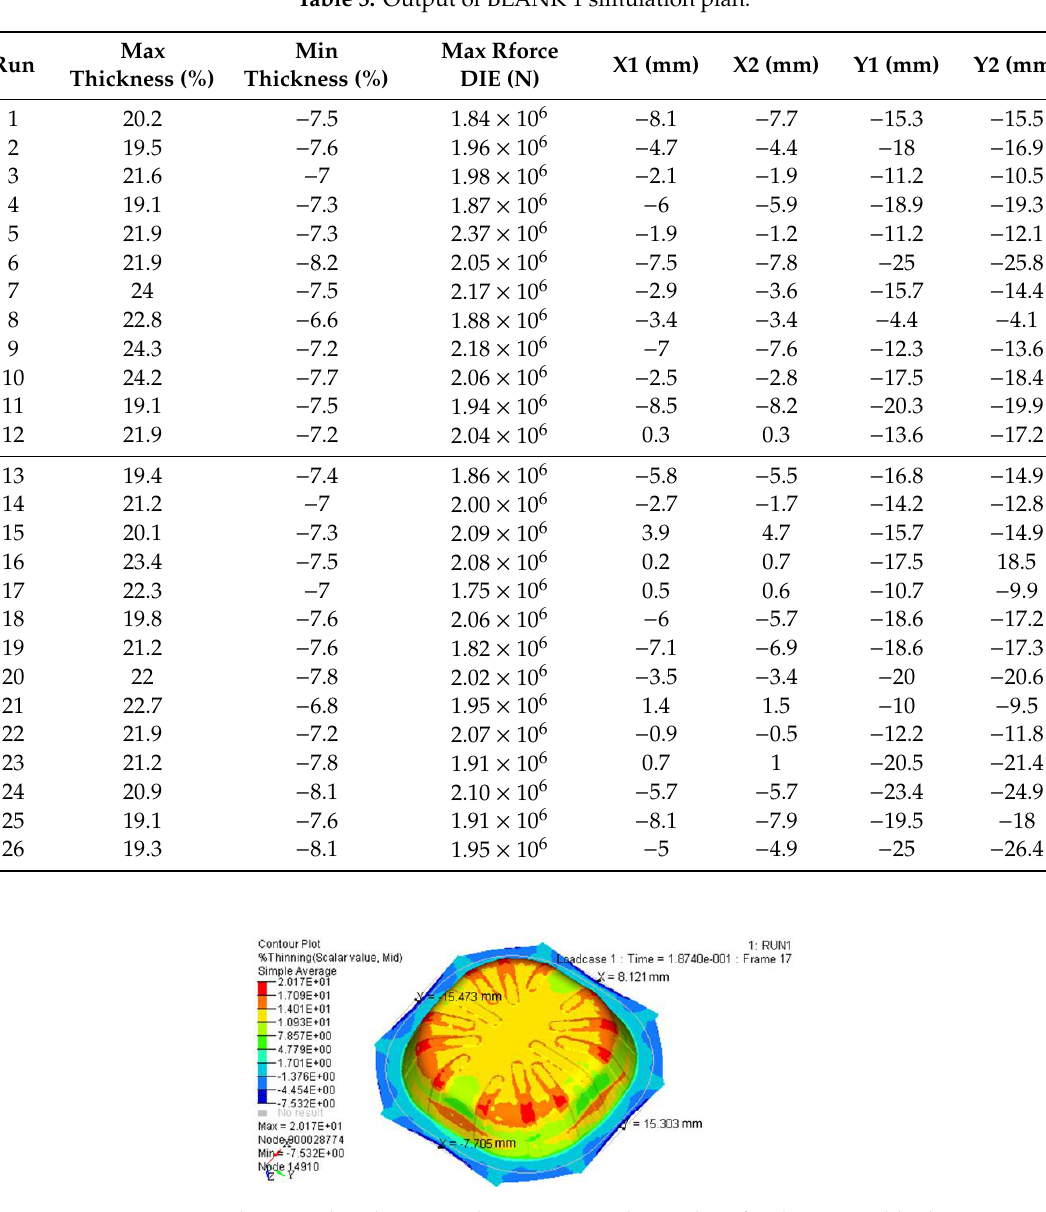
Figure 13. Reaction force curves comparison between RUN20 and RUN22; blank0. Figure 14. Punch displacement with stepwise, in correspondence of S and T1. TT represents the last point of the curve with maximum value in the x axis; blank0.